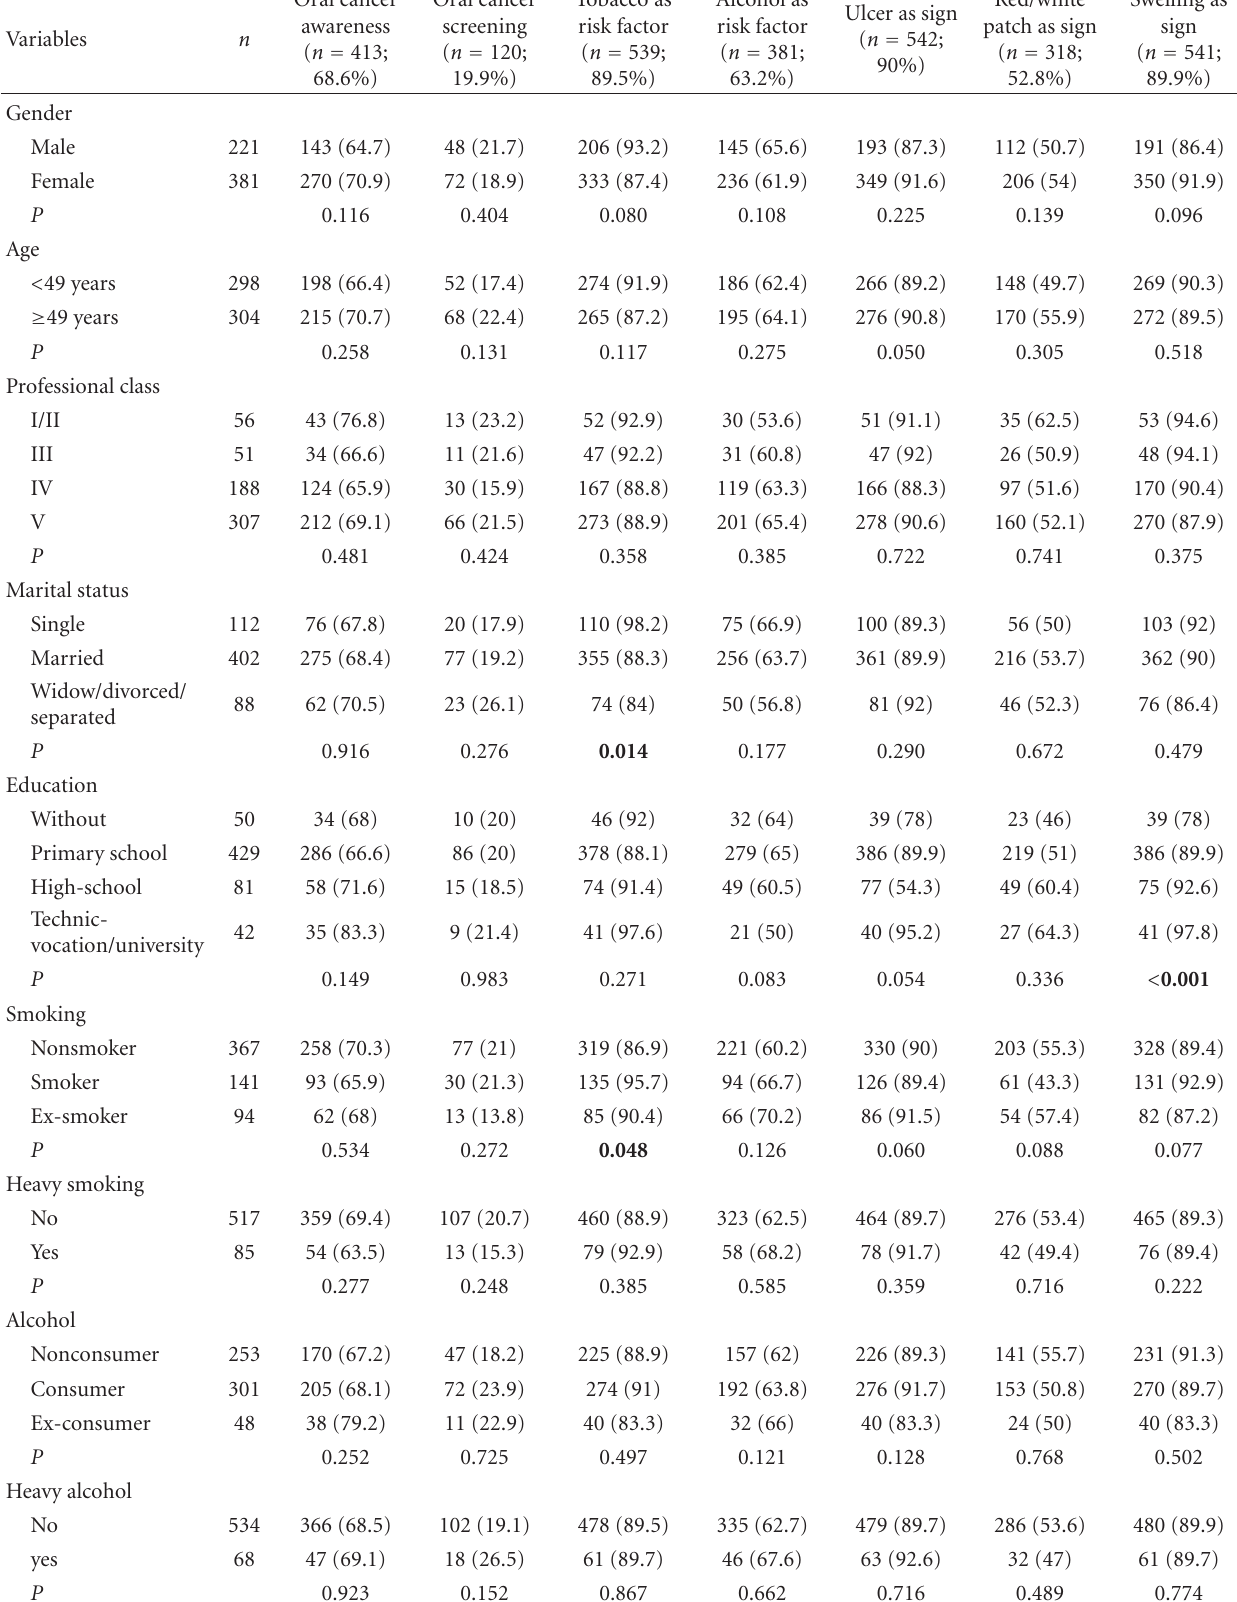
Table 1: Sociodemographic characteristics and their relations with some awareness and knowledge